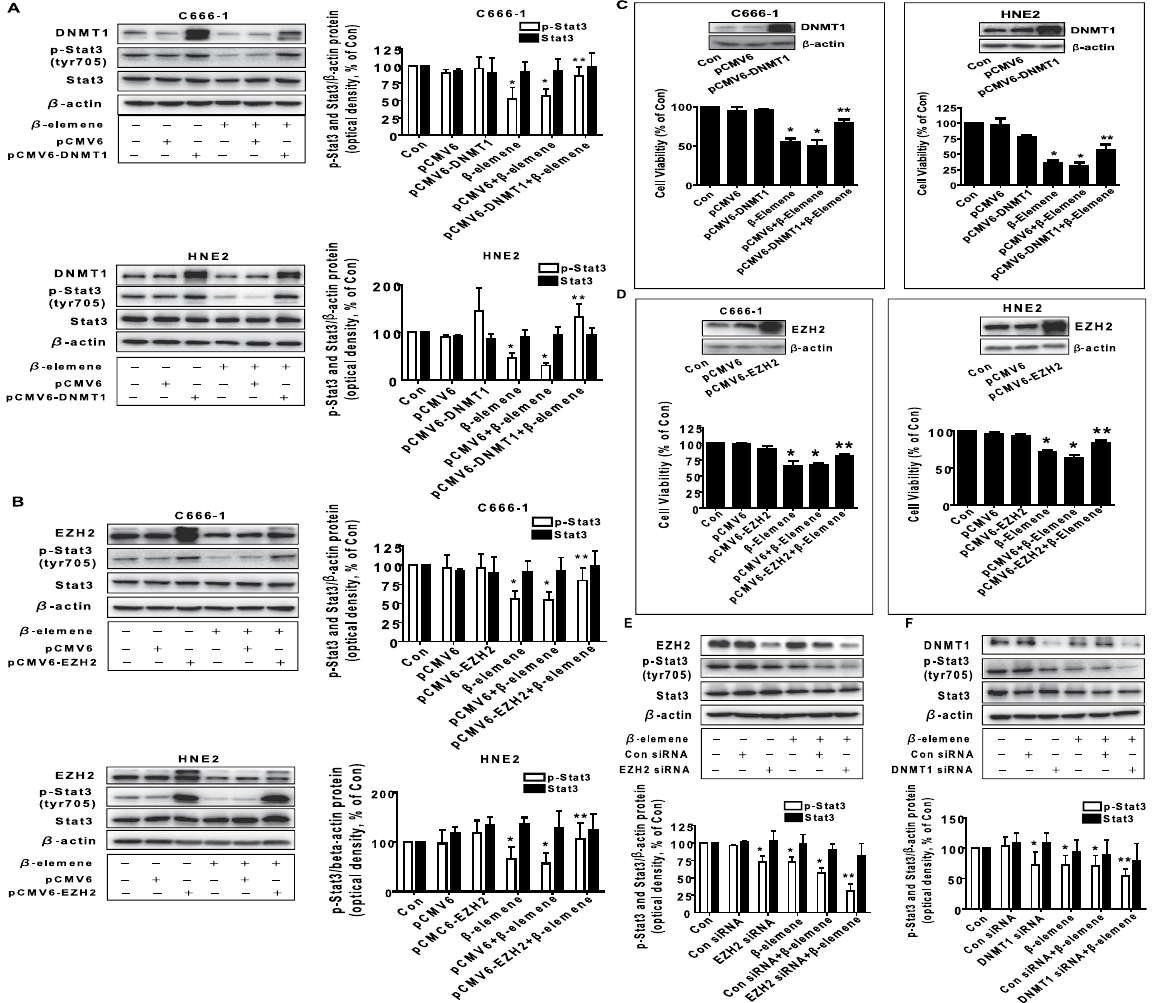
Figure 5. Exogenously expression of DNMT1 or EZH2 feedback reversed the effect of β -elemene on phosphorylation of Stat3 and cell growth inhibition. ( A,B ) C666-1 and HNE2 cells were transfected with control or DNMT1 or EZH2 expression vectors for 24 h prior to exposure of the cells to β -elemene (20 μ g/mL) for an additional 24 h. Afterwards, Western blot analysis were used measure the levels of DNMT1 and EZH2, and p-Stat3, Stat3 proteins using corresponding antibodies. ( C,D ) C666-1 and HNE2 cells were transfected with control or DNMT1 or EZH2 expression vectors for 24 h prior to exposure of the cells to β -elemene (20 μ g/mL) for an additional 48 h. Afterwards, cell proliferation was examined by MTT assays as described in the Materials and Methods section. Insert blots represented protein expressions of DNMT1 and EZH2. ( E,F ) C666-1 cells were transfected with control or DNMT1 or EZH2 siRNAs for 30 h prior to exposure of the cells to β -elemene (20 μ g/mL) for an additional 24 h. Afterwards, Western blot analysis were used measure the levels of DNMT1 and EZH2, and p-Stat3, Stat3 protein using corresponding antibodies. The figures are representative cropped gels/blots that have been run under the same experimental conditions. Values in bar graphs were given as the mean ± SD from three independent experiments performed in triplicate. * Indicates significant difference as compared to the untreated control group (P < 0.05). ** Indicates significant difference from the β -elemene treated alone (P <